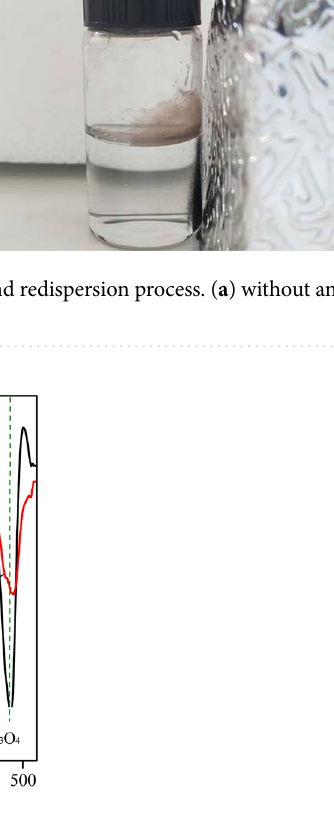
Figure 10. FTIR spectra of 6O-MWCNTs@Fe 3 O 4 after Pb(II)